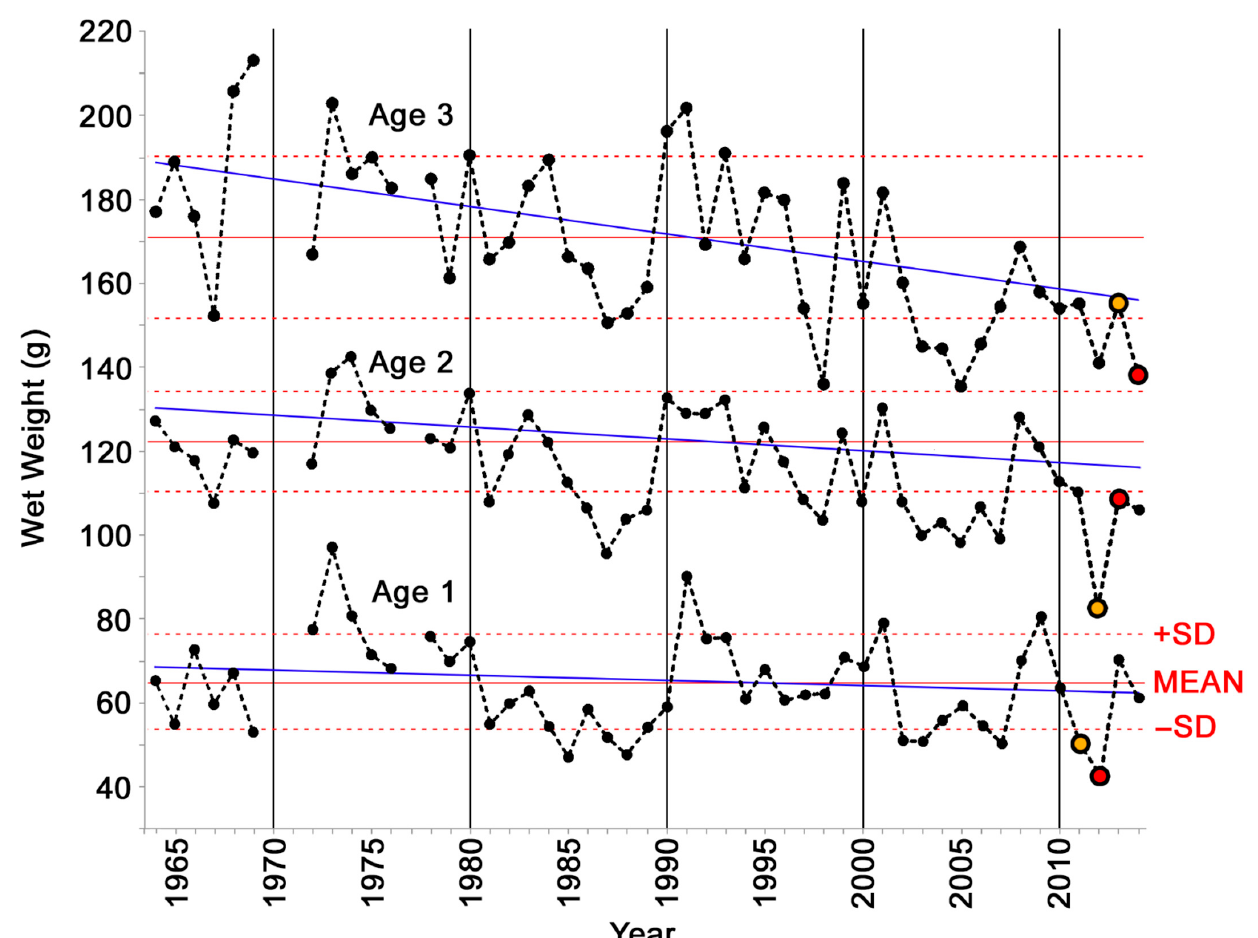
Figure 2. Weight of age-1, age-2 and age-3 Gulf menhaden sampled at the Daybrook Fisheries, Inc. port at Empire, LA for the National Marine Fisheries Service port sampling program, 1964 to 2014. Regressions (blue lines) based on 1964 = year zero are: age 1, wet wt. = 68.1–0.134 × year ( p = 0.31, df = 42); age 2, wet wt. = 130–0.328 × year ( p = 0.015, df = 42); and age 3, wet wt. = 189–0.769 × year ( p < 0.001, df = 42). The difference between slopes at ages 2 and 3 are significant ( p < 0.001). Orange- and red-filled dots, respectively, indicate the 2010 and 2011 year classes. 95% confidence intervals lie within the black or colored dots.